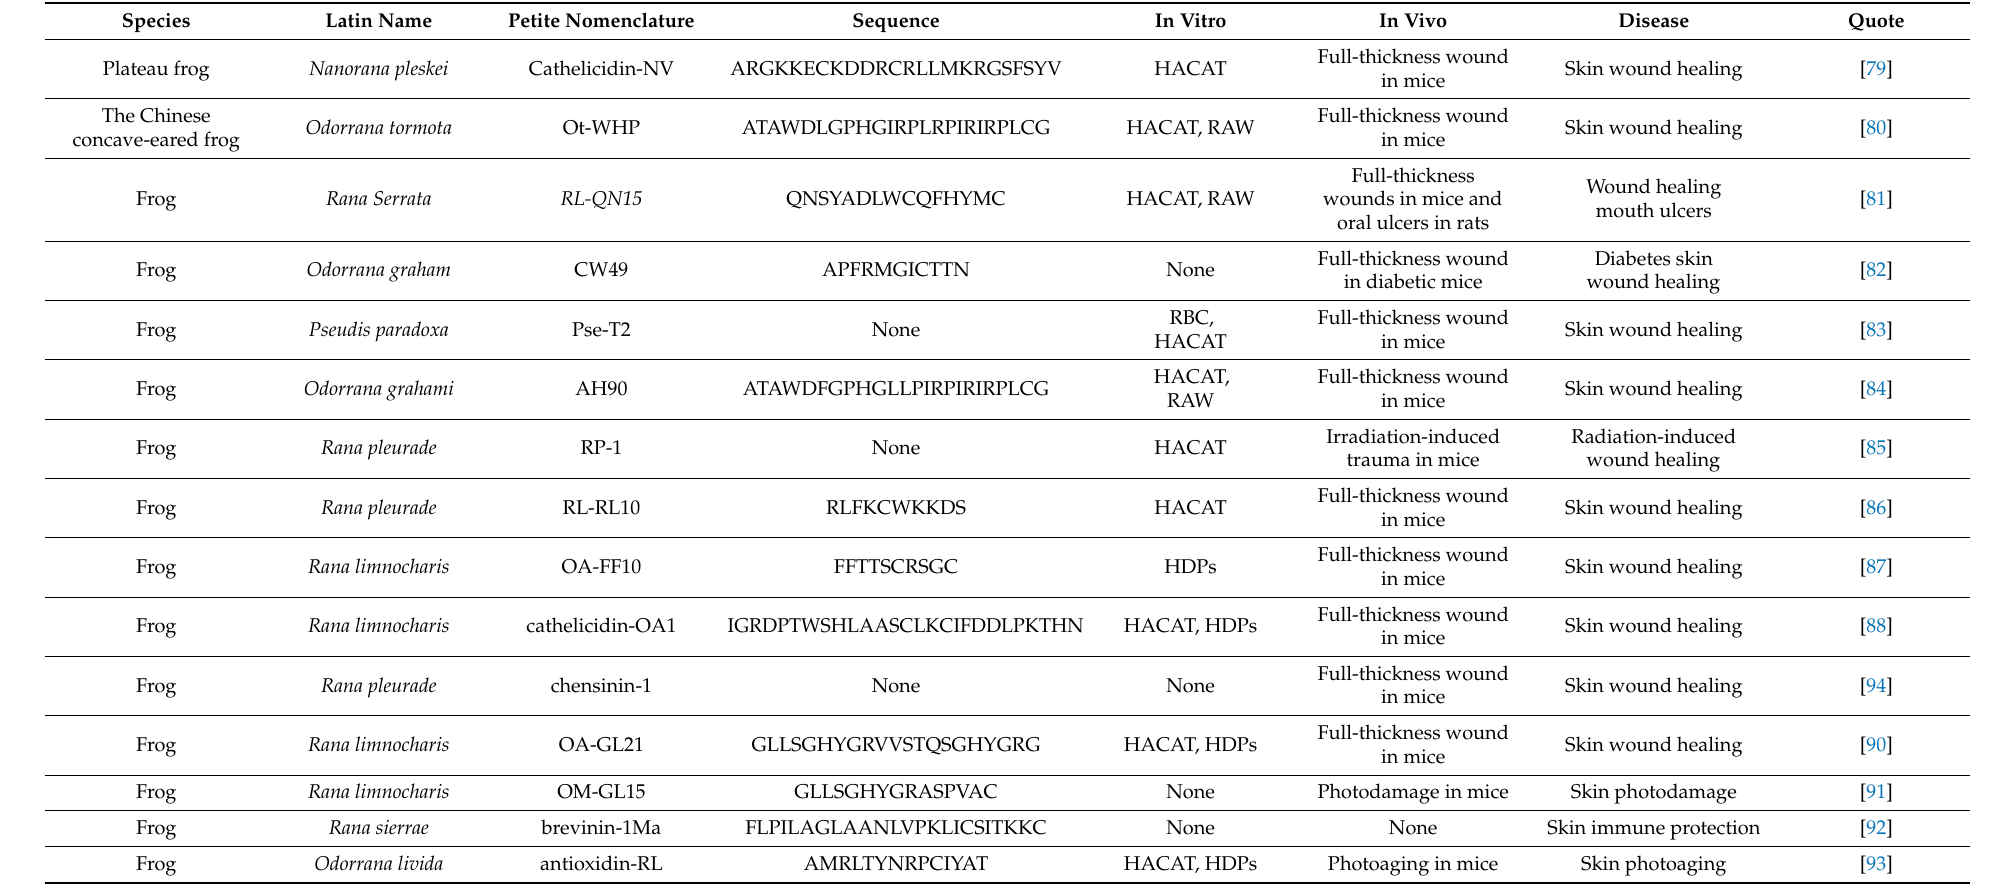
Table 1. Amphibians for skin